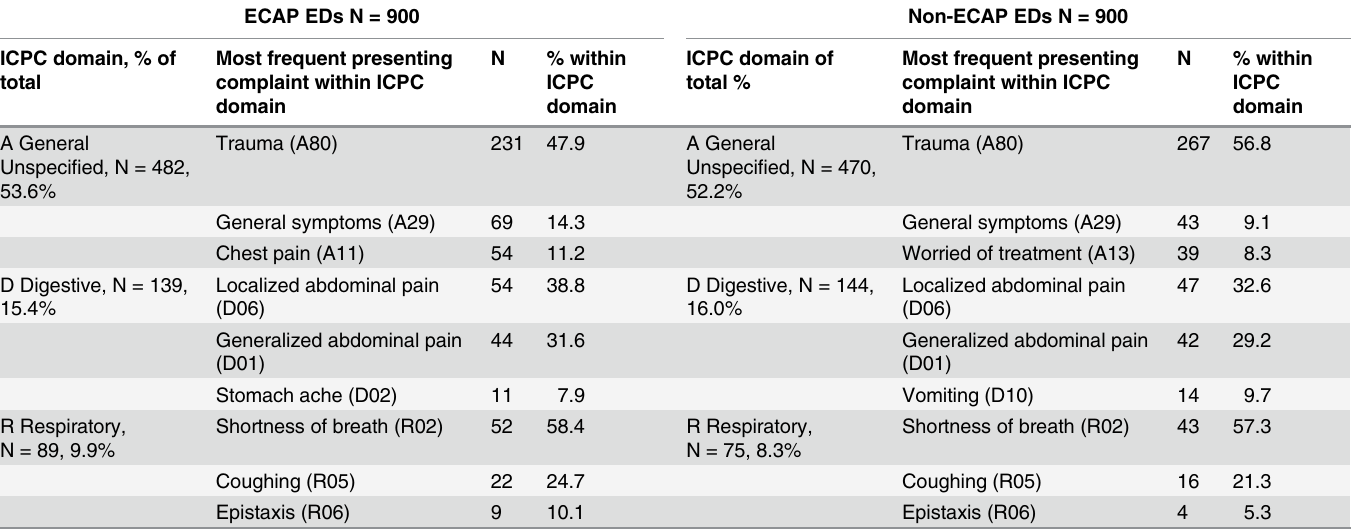
Table 4. Most frequent presented ICPC domains.